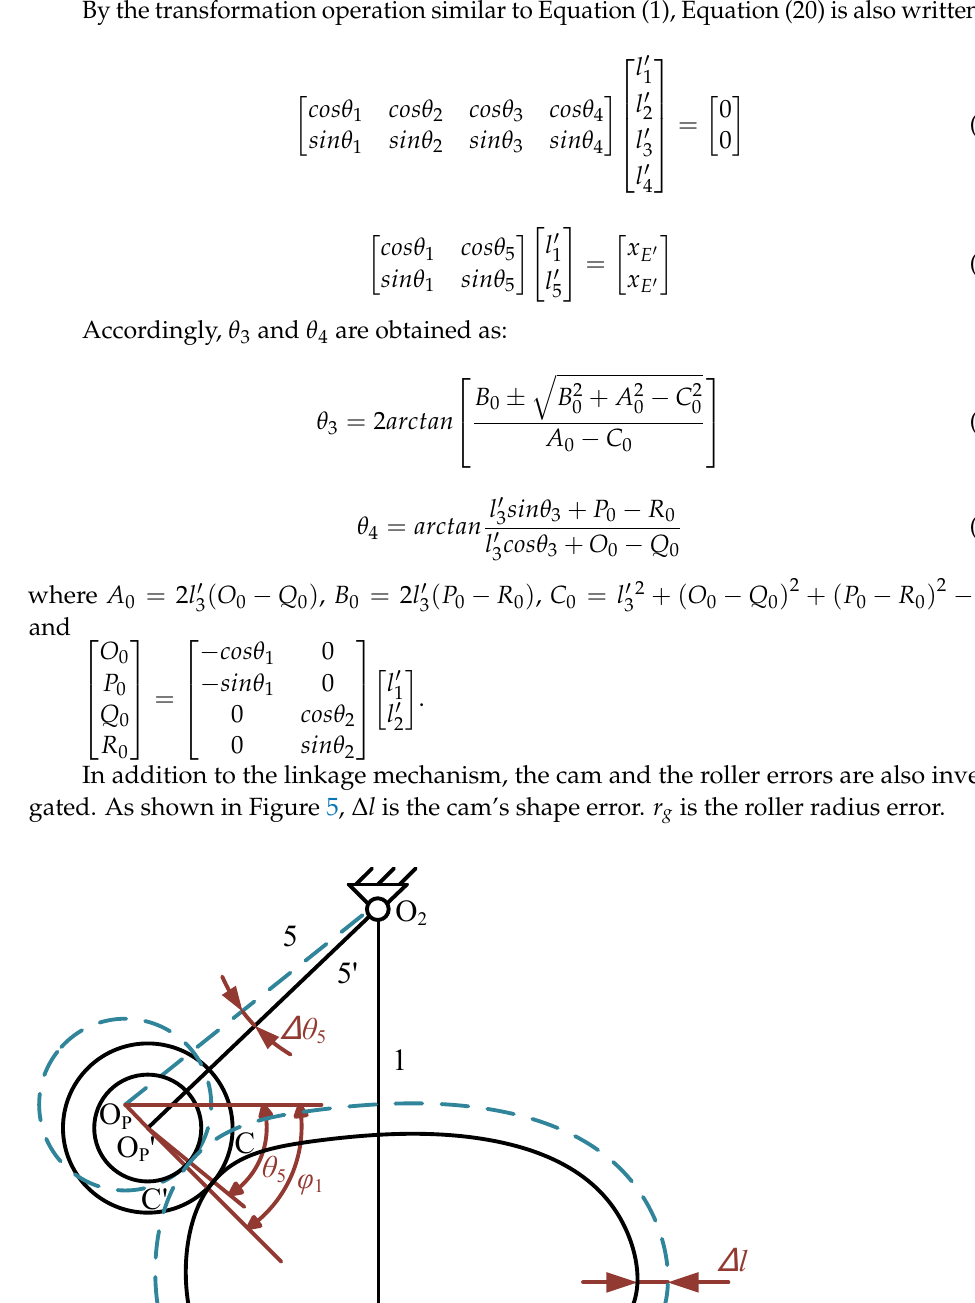
where δ indicates the combined error of roller radius and cam geometry, δ = ∆ l + r g